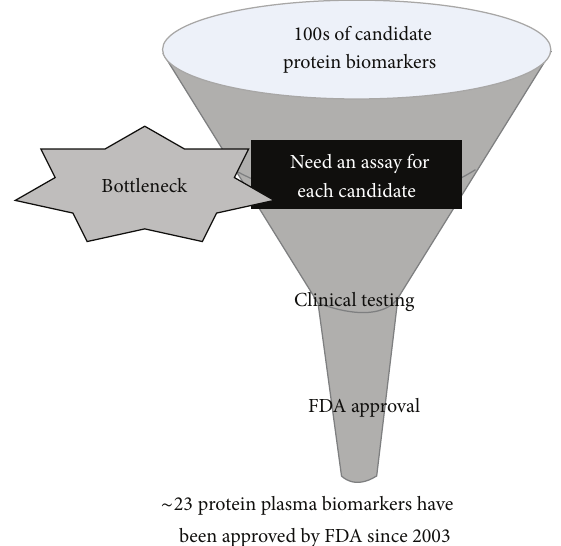
Figure 2: The assay bottleneck prevents potential protein diagnos- tics from becoming clinically